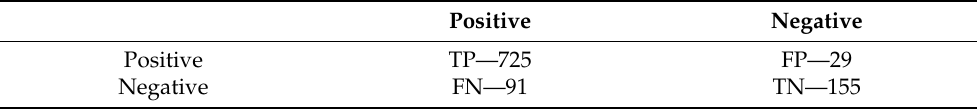
Table 7. Confusion matrix of the classification results.